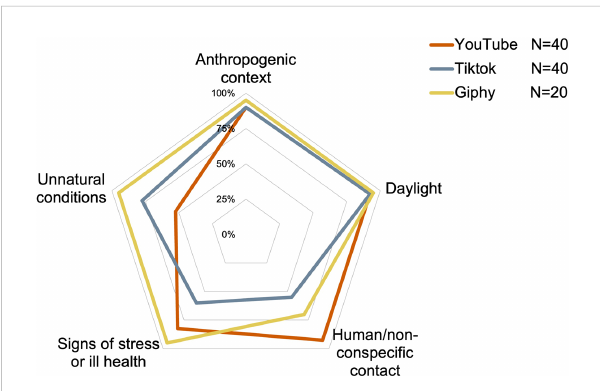
FIGURE 2 Radar chart representing the prevalence of the fi ve decontextualization conditions for videos analysed on YouTube (N=40), TikTok (N=40), and Giphy (N=20), illustrating differences in decontextualization between the three SMPs.